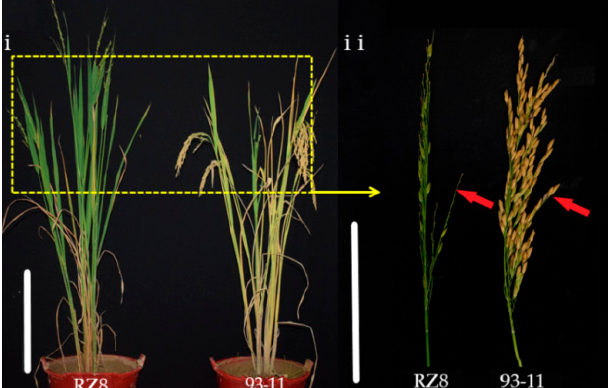
Figure 5. Phenotypic variation of grain shattering in RZ8 and 93-11; Whole plant phenotype showing grain shattering (bar = 50 cm), grain shattering (bar = 10 cm, red arrows).